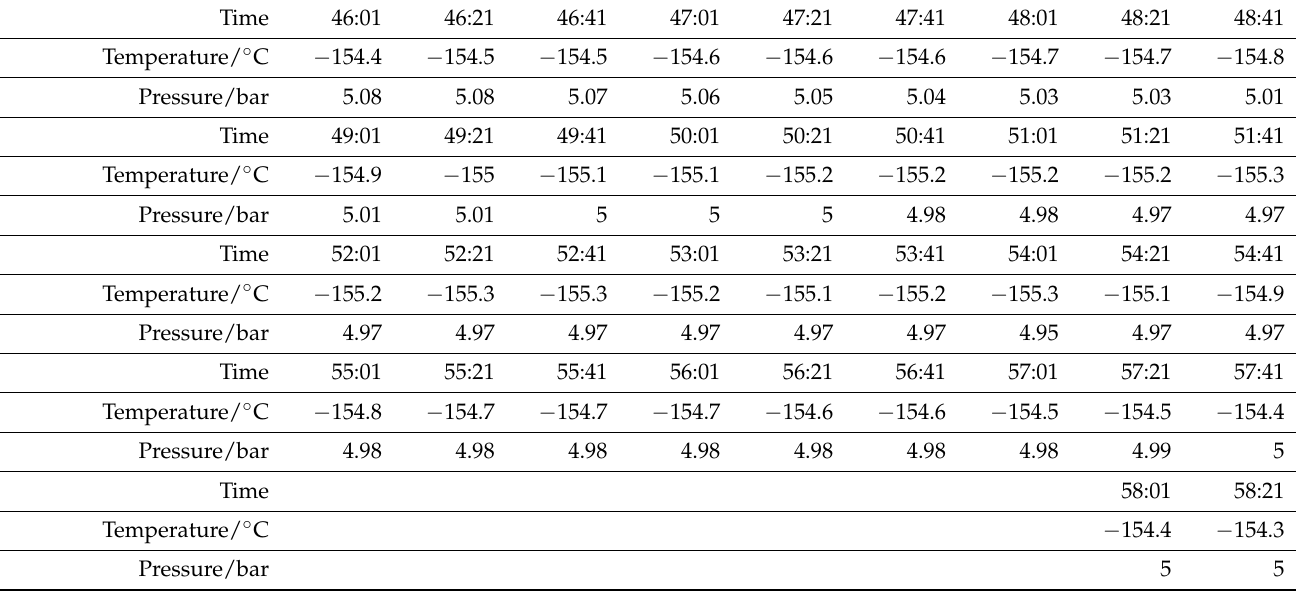
Table 1. Temperature and pressure data recorded by paperless